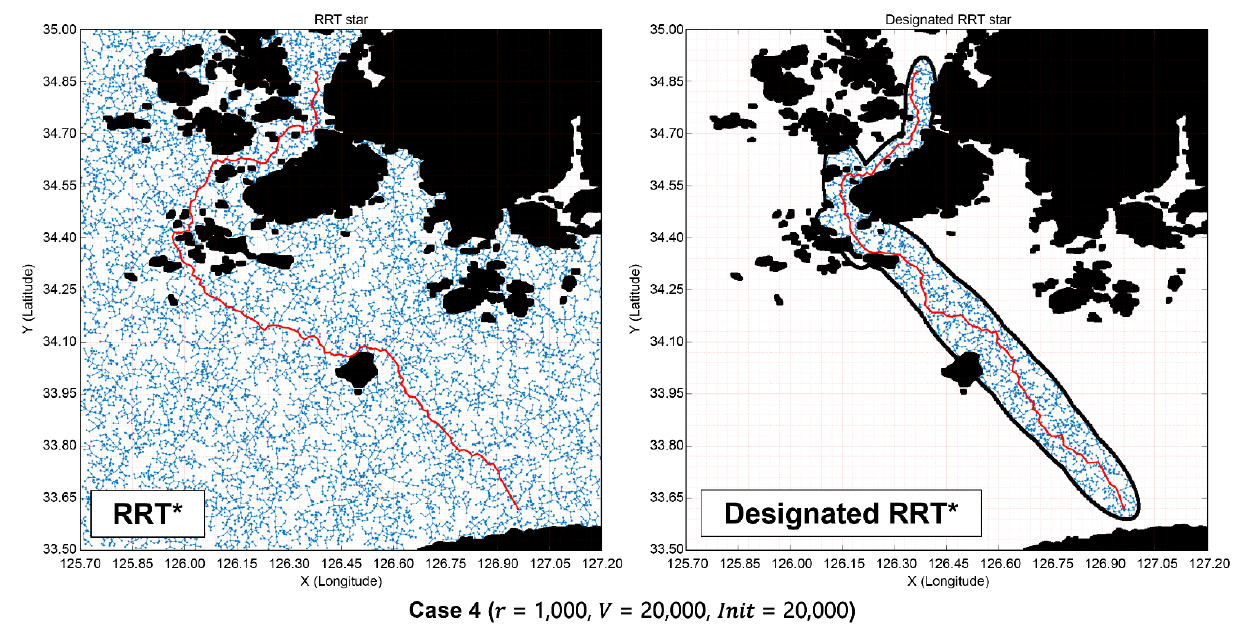
Figure 23. Comparison of the simulation results (Case 3).